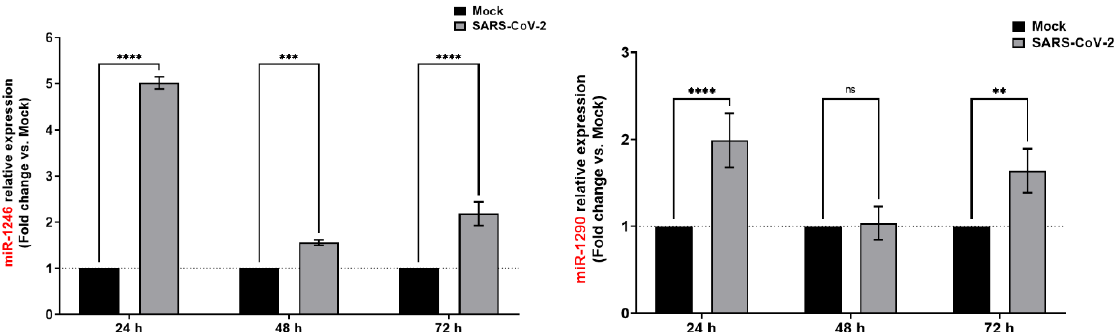
Figure 6. Validation of miR-1246 and miR-1290 upregulation (RNA-Seq data) by qPCR. miR-1246 and miR-1290 were monitored by RT-qPCR upon SARS-CoV-2 infection in Calu-3 cells. qPCR data were normalized to a reference gene (U6 snRNA), reported to mock and expressed with a relative quantitation method (ddCT). Statistical analysis. All data presented were calculated from three biological replicate ( n = 3) measurements ± SD. The ordinary two-way analysis of variance (ANOVA) and Šídák’s multiple comparisons test were used for statistical analysis. Statistically significant differences (fold change vs control) are indicated by stars (*): ** p < 0.01; *** p < 0.001; **** p < 0.0001. ns, nonsignificant.